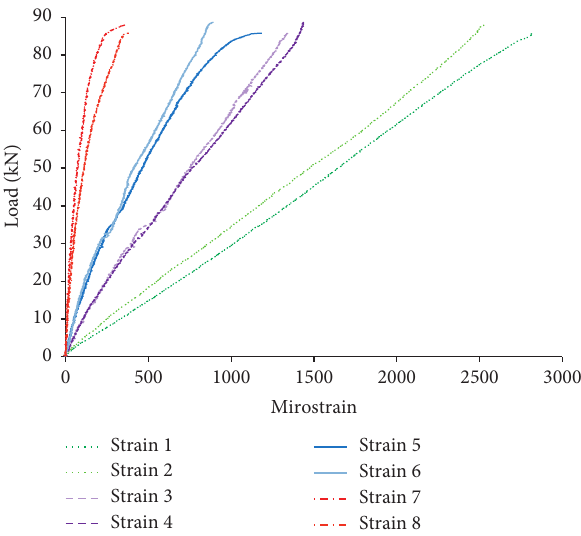
Figure 12: Ribbed bar-reinforced GPC pull-out load and steel strain relationship.